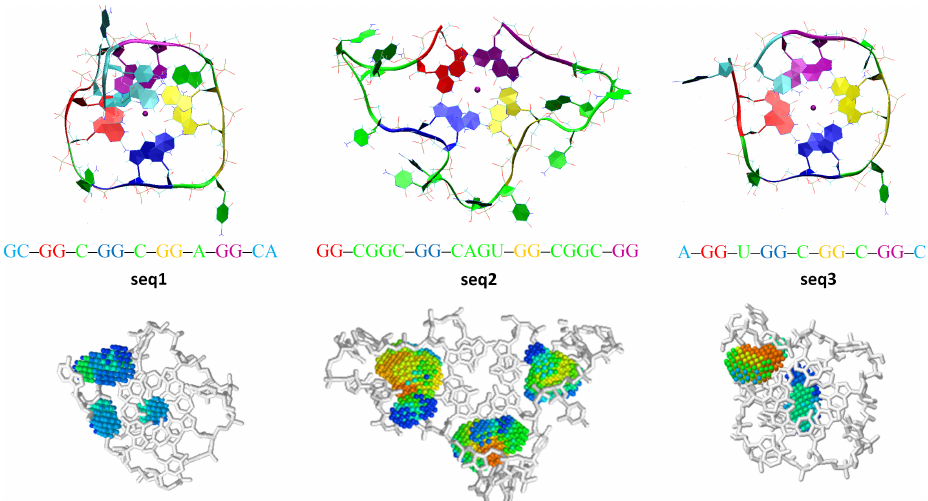
Figure 3. Top : The three RNA G-quadruplex systems located in the 5 (cid:48) -UTR of the KRAS transcript, which are stable at room temperature according to molecular dynamics simulations with a polarizable force field (AMOEBA). Seq1 and seq3 are both very stable thanks to their single-nucleotide loops and cap fragments. Bottom : Assessment of the binding pockets in the seq1, seq2 and seq3 GQ topologies. The deep potential binding pockets are located inside long loops of the least stable seq2 quadruplex, which could be stabilized with small